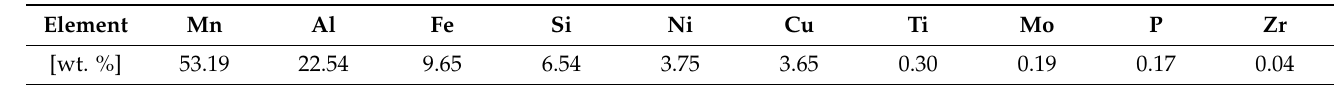
Table 2. Chemical composition of the alloy (in wt. %) prepared by reduction with a 100% excess of